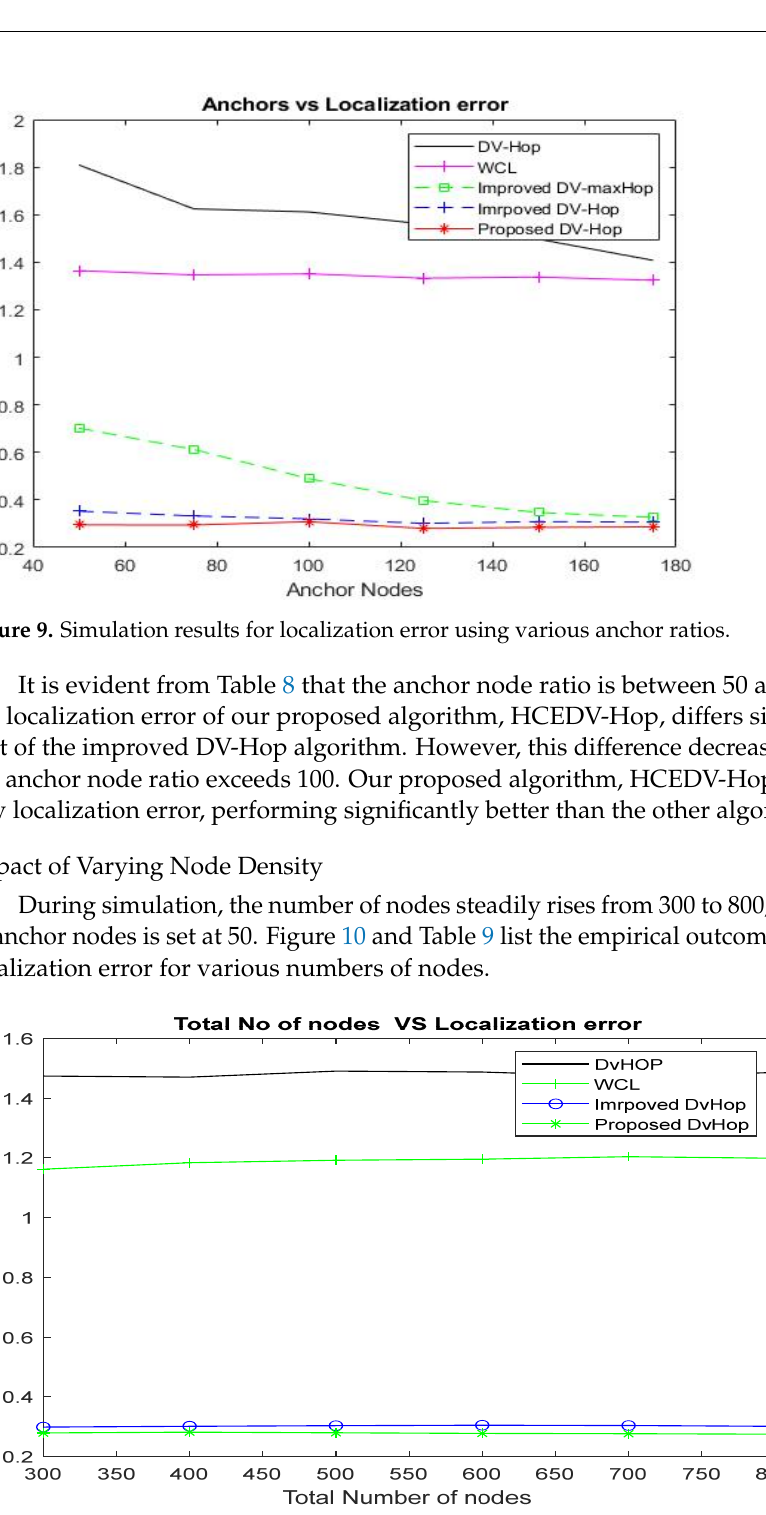
Figure 10. Simulation results of ALE using various total numbers of nodes.